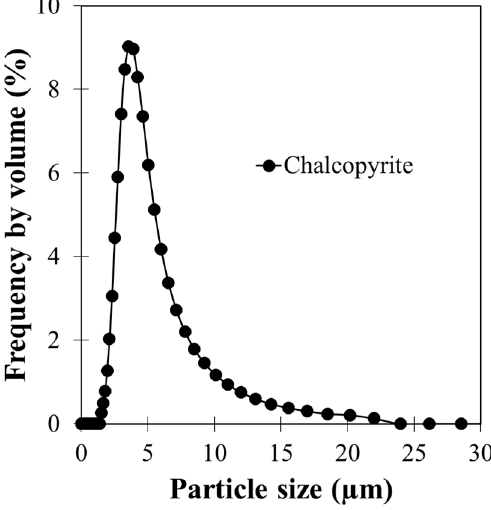
Figure 3. Particle size distribution of chalcopyrite sample.